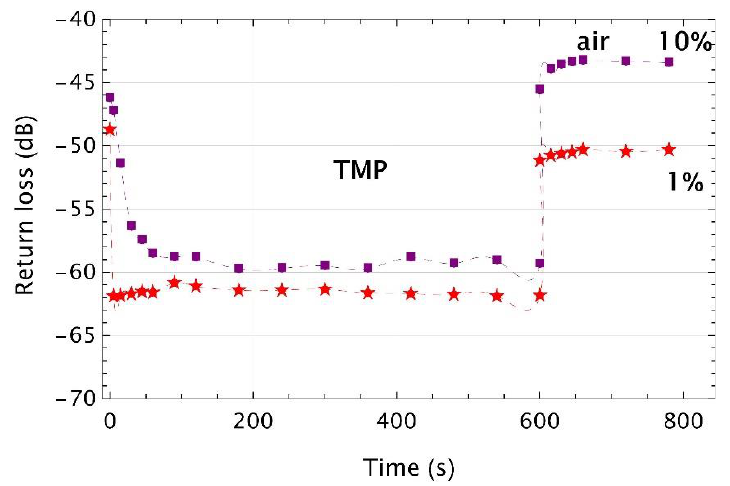
Figure 11. Time responses of the UV microtips made with the monomer mixture enriched with TEOS cross-linking additive and with APTES treated optical fiber exposed to vapors of the TMP of a volume of 100 µL. Markers are experimental points, while the dashed lines are their cubic polynomial interpolations.